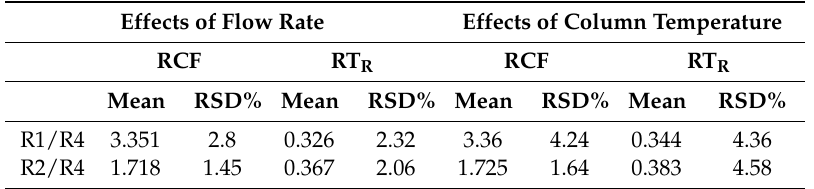
Table 4. Effects of flow rate and column temperature upon RCF and RT R